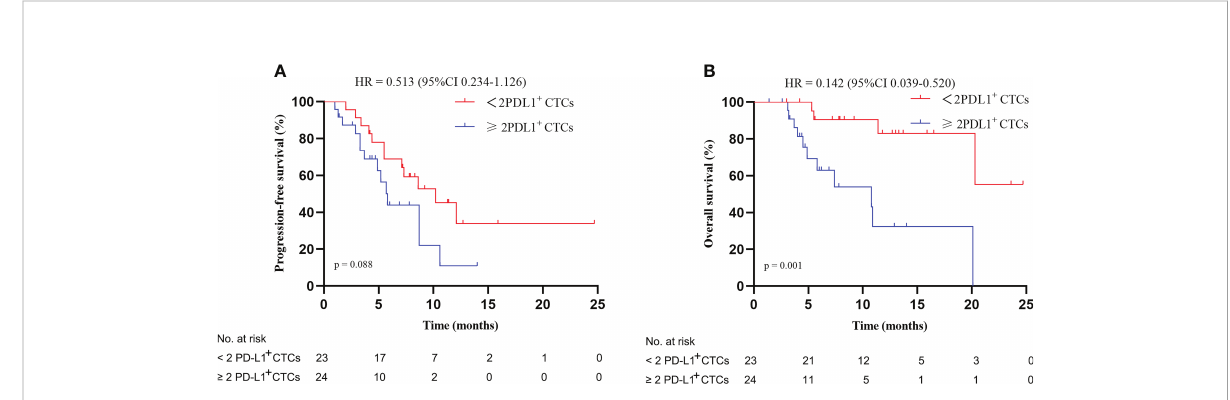
FIGURE 3 Kaplan – Meier plots: (A) progression-free survival and (B) overall survival based on PD-L1 expression on CTCs at baseline. HR, hazard ratio; CI, con fi dence interval; CTCs, circulating tumor cells; PD-L1, programmed death-ligand 1.